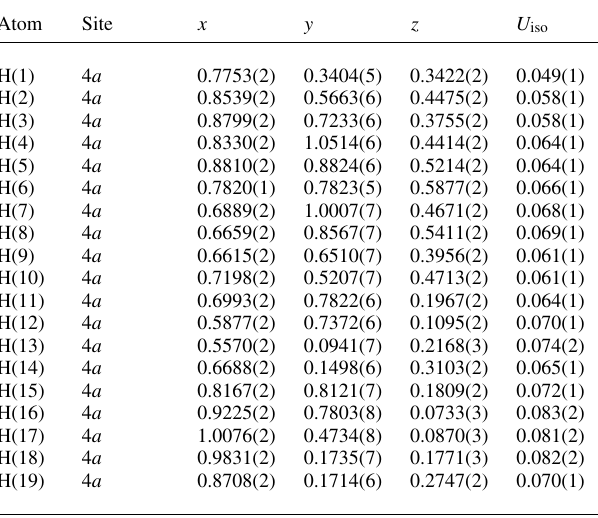
Table 2. Atomic coordinates and displacement parameters (in Å 2 )